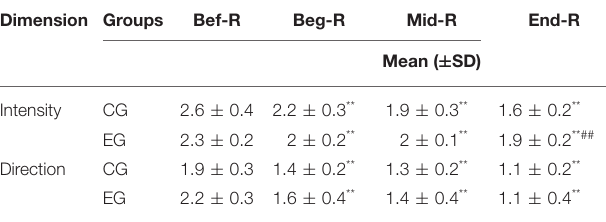
TABLE 6 | Variation in the dimensions of self-confidence recorded before and during Ramadan. Dimension